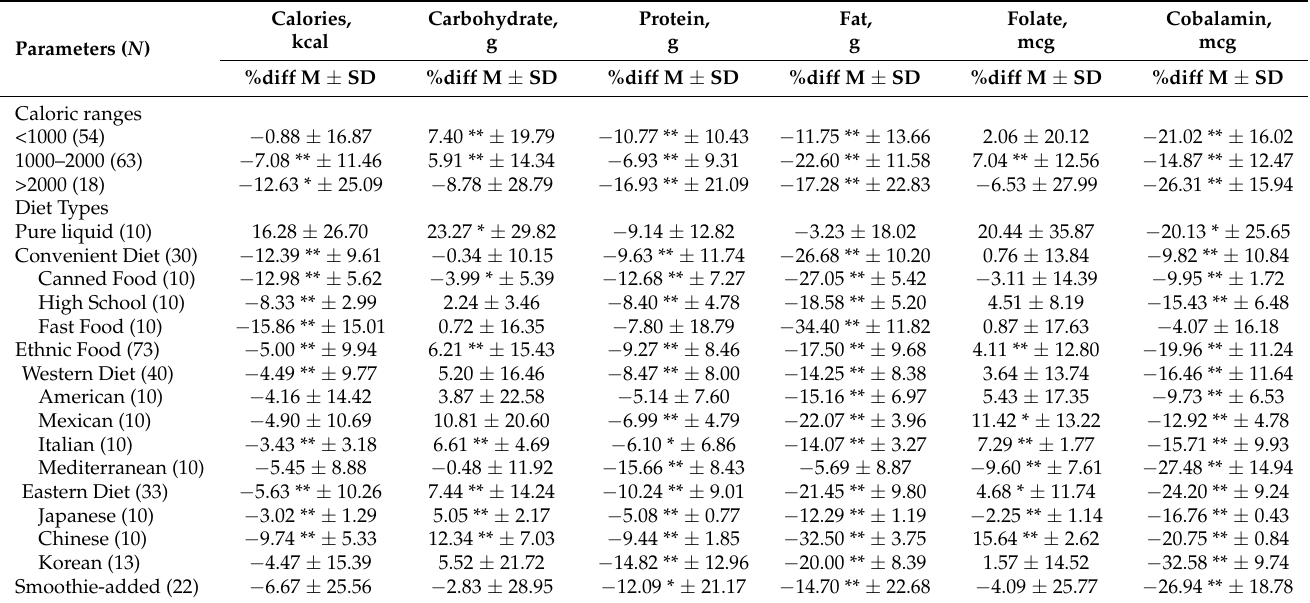
Table 2. Differences between the mobile application and Food Frequency Questionnaire per domains of caloric ranges and various diets for key macro- and micro-nutrients ( N =